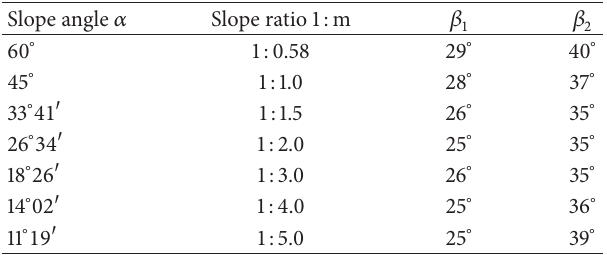
Table 13: Determination of 𝛽 1 and 𝛽 2 with slope angle 𝛼 .